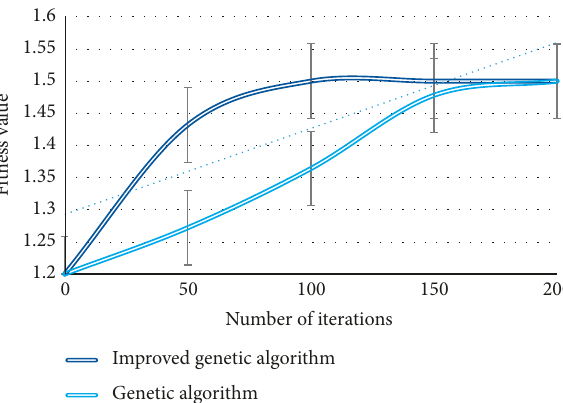
Figure 1: Convergence characteristics comparison chart of im- proved genetic algorithm and traditional genetic algorithm.